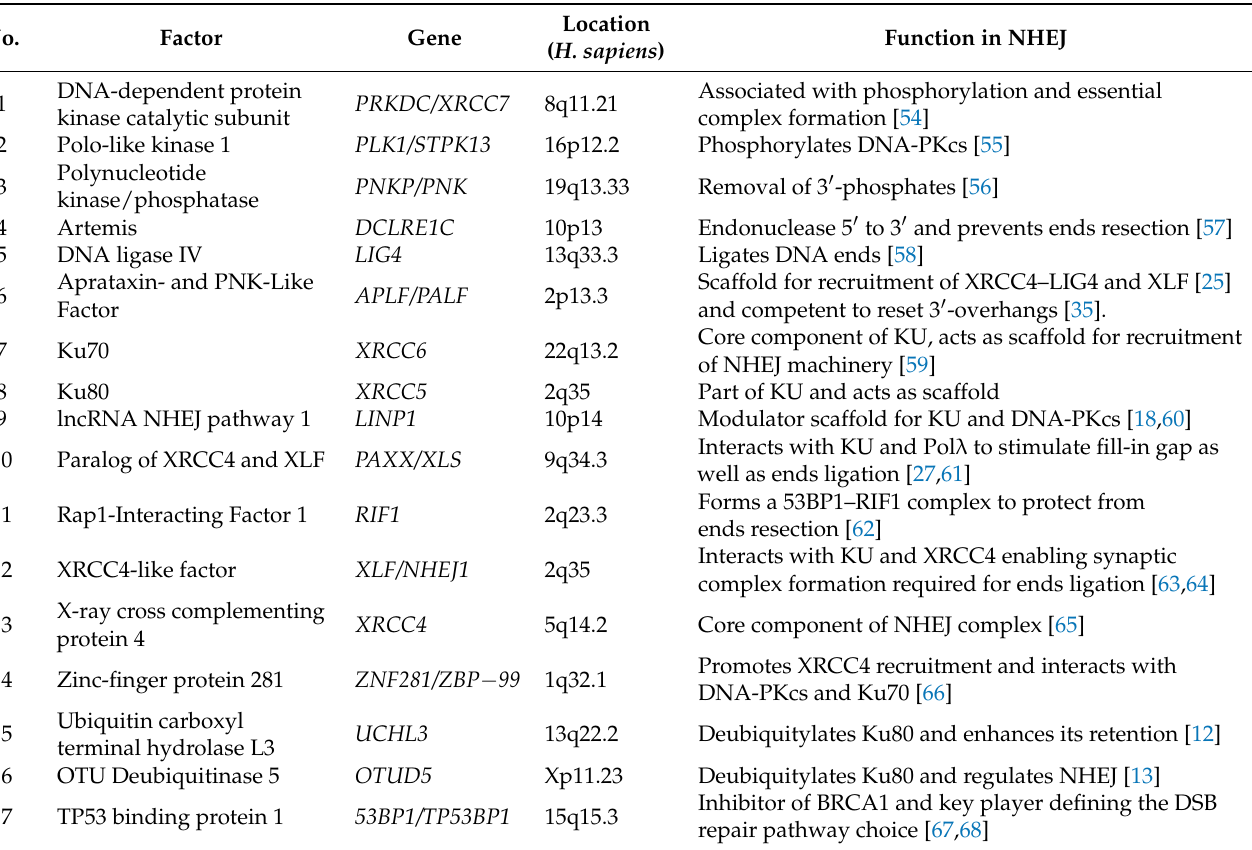
Table 1. NHEJ-associated key factors with gene location based on human genome assembly (GRCh38.p14) and their